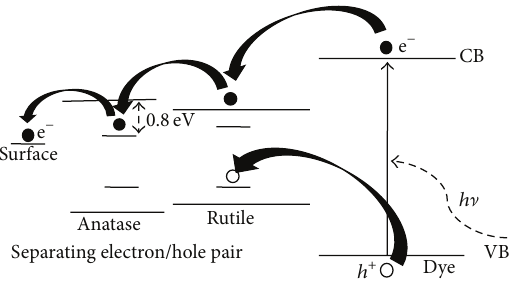
Figure 7: Energy diagram and carrier transportation of mixed- phase TiO 2 nanoparticles.